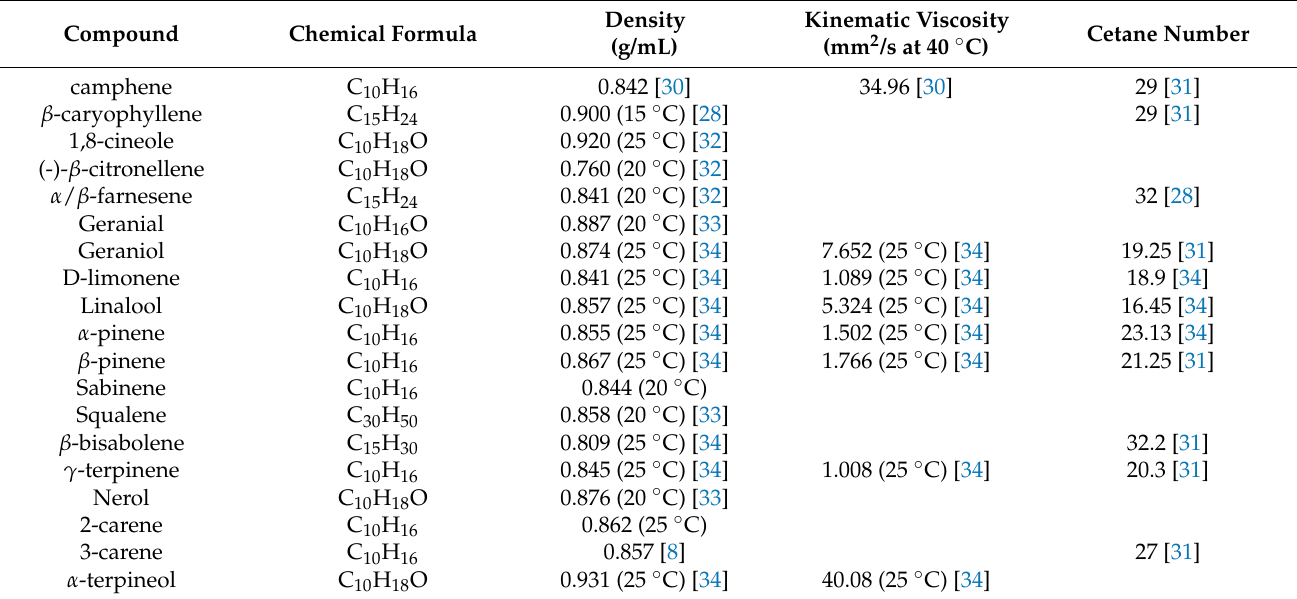
Figure 3. Main terpenes and terpenoids. Turpentine is a collective name representing a natural product that can be obtained from different processes. It is mainly obtained via the distillation of resin harvested from living trees, mainly pines. It is mainly composed of monoterpenes but also of small quan- tities of sesqui-terpenes. The main compounds found in turpentine are α -pinene and β - pinene with very low amounts of D-limonene, camphene, and myrcene. Turpentine has a higher olefinic nature, as compared to hydrogenated and oxidized turpentine. Using vac- uum distillation of pine resin, barely 20% of turpentine can be obtained. The bottom of vacuum distillation is rosin, representing 80% w / w of the resin, and represented by diter- penes with carboxylic acid functionality [7,29]. Turpentine has been formerly used as a solvent in paints, but it was banished by much cheaper petroleum derivatives. For this